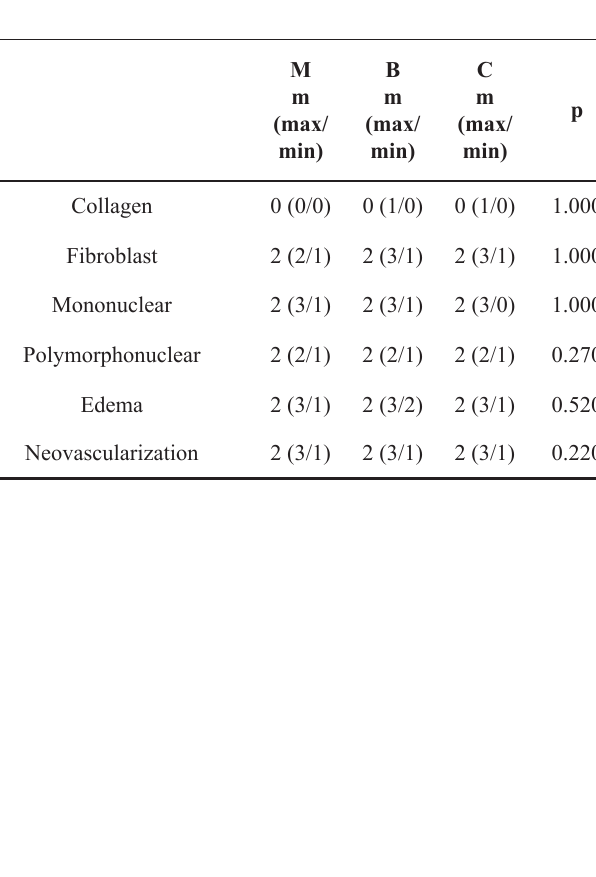
(max) of scores of histopathological analysis of abdominal wall scar samples, animals killed three days after surgery. Groups